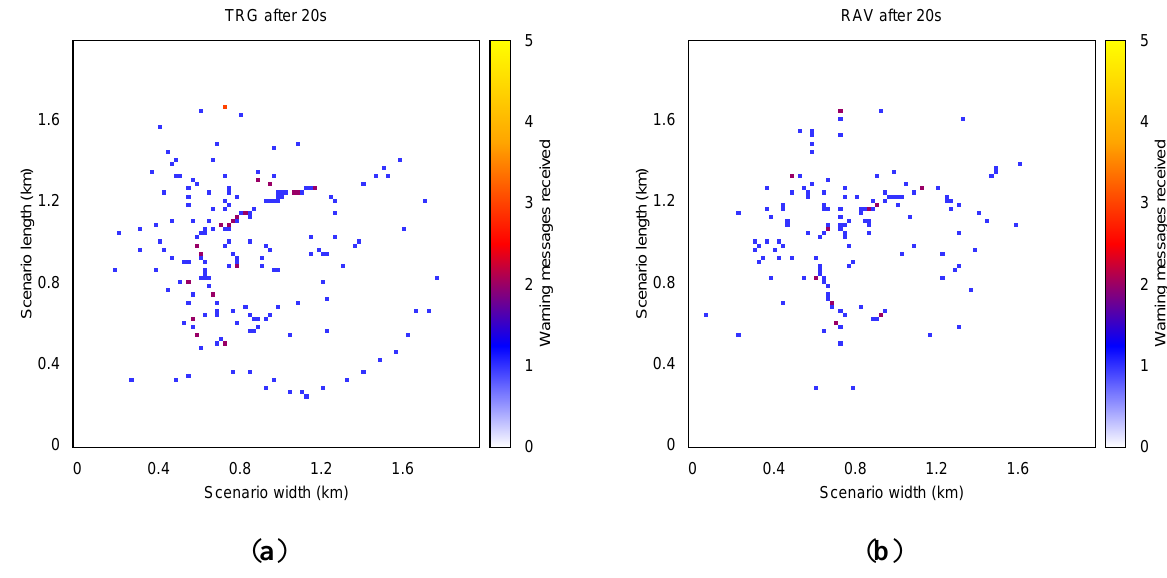
Figure 4. Evolution of the warning message dissemination process in the Rome scenario after 20 s, when using ( a ) the TwoRay Ground and ( b ) the RAV